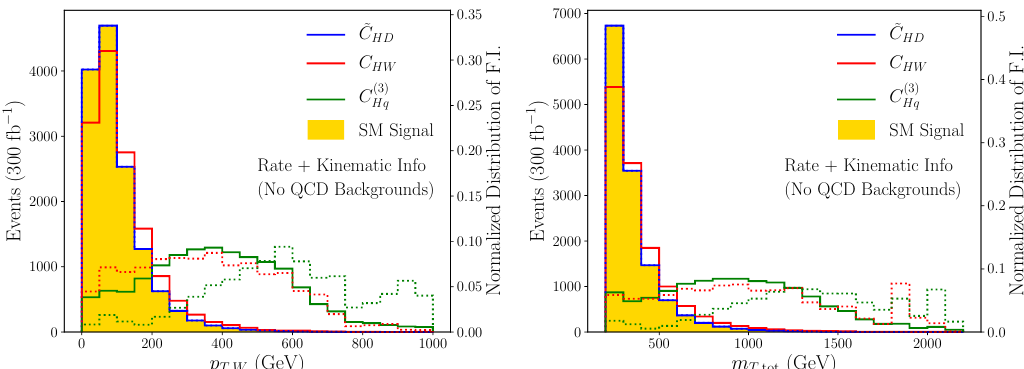
Figure 2 . Left axis: SM signal distribution. Right axis: normalized distributions of the diagonal elements of the Fisher information, representing the information on the three Wilson coe(cid:14)cients in bins of p T;W (left panel) and m T; tot (right panel). The solid lines are linearized in the Wilson coe(cid:14)cients, while the dotted lines show the information on the dimension-6 squared terms.